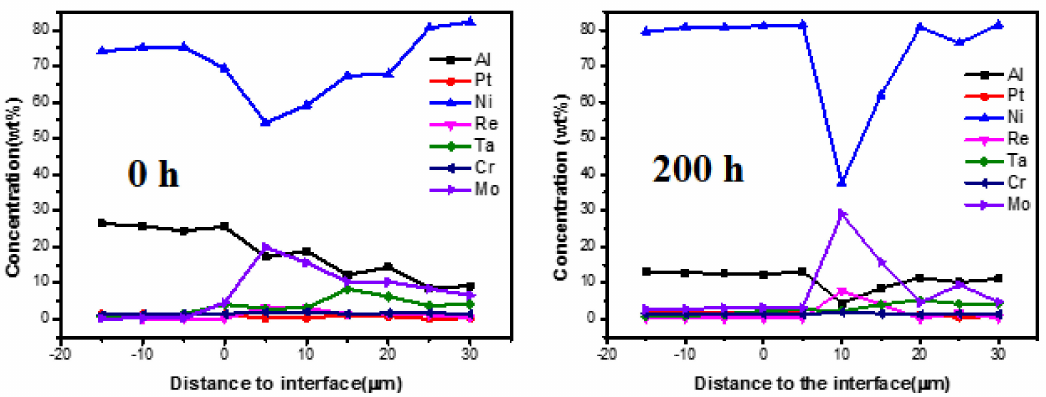
Figure 5. The elemental distributions of the samples before (0 h) and after 200 h thermal exposure by